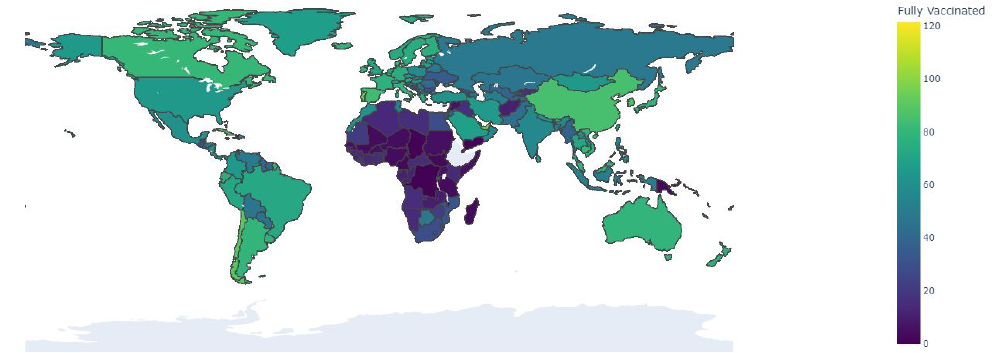
Figure 2. Choropleth map of vaccination around the globe by 15 February 2022. It presents the share of people who received all doses prescribed by the initial vaccination protocol, divided by the total population of the